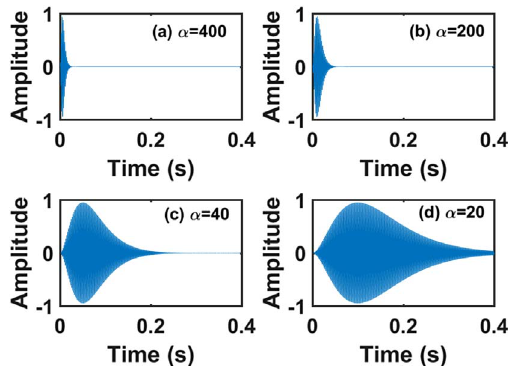
Figure 2. Some tone-pips for c = 3, f 0 = 500 Hz